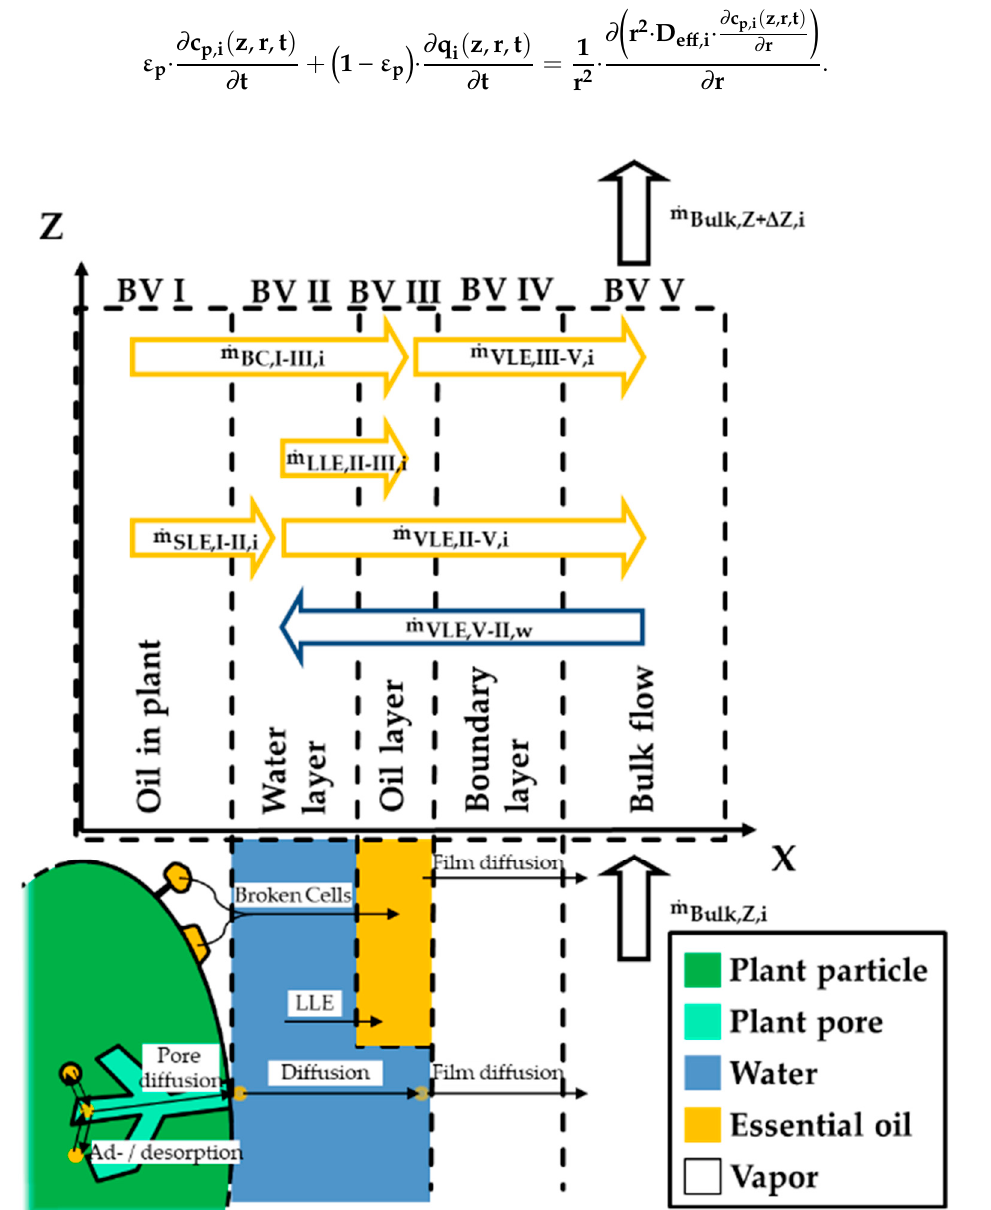
Figure 6. Model overview, including cell disruption for “free” oil, liquid–liquid equilibrium, solid–liquid extraction for oil in plant particle and condensation of water. LLE: liquid–liquid extraction.